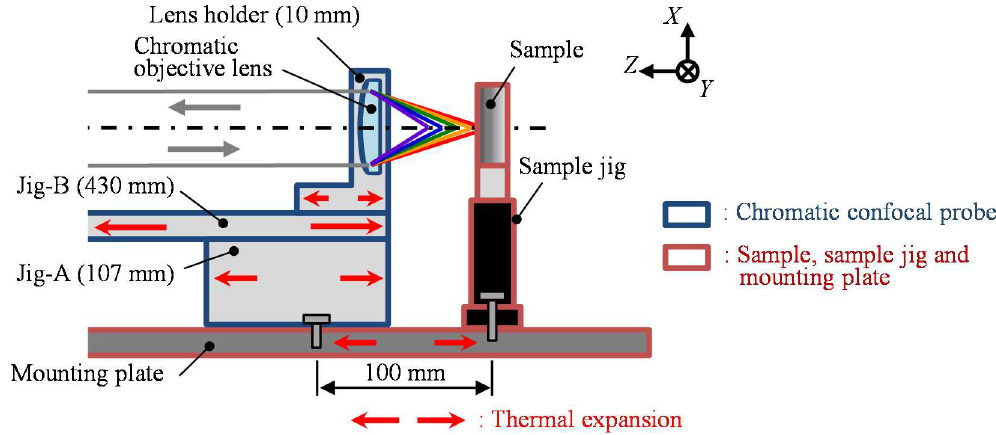
Figure 7. A detailed schematic of the chromatic confocal lens and the target sample in the chromatic confocal measurement setup shown in Figure 2b.